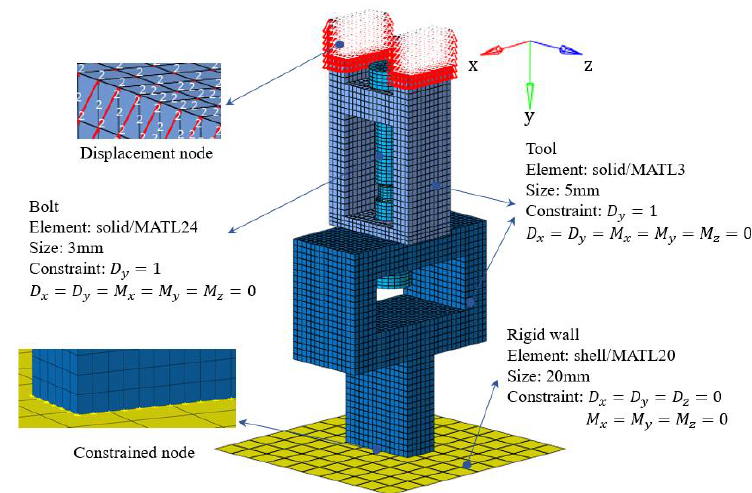
Figure 10. Finite element model of tooling structure for the VCSB tensile test.